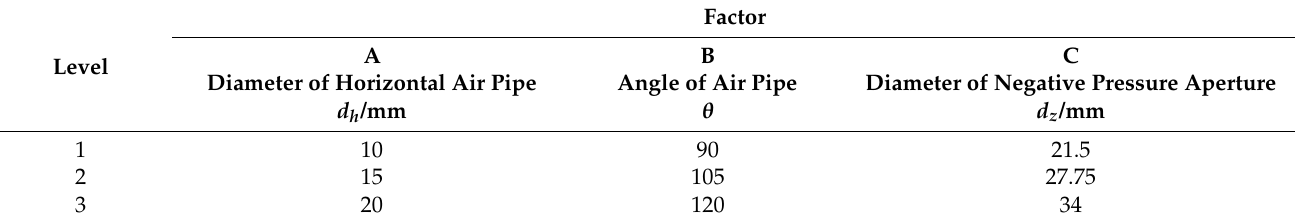
Table 1. Experiment factors and levels.